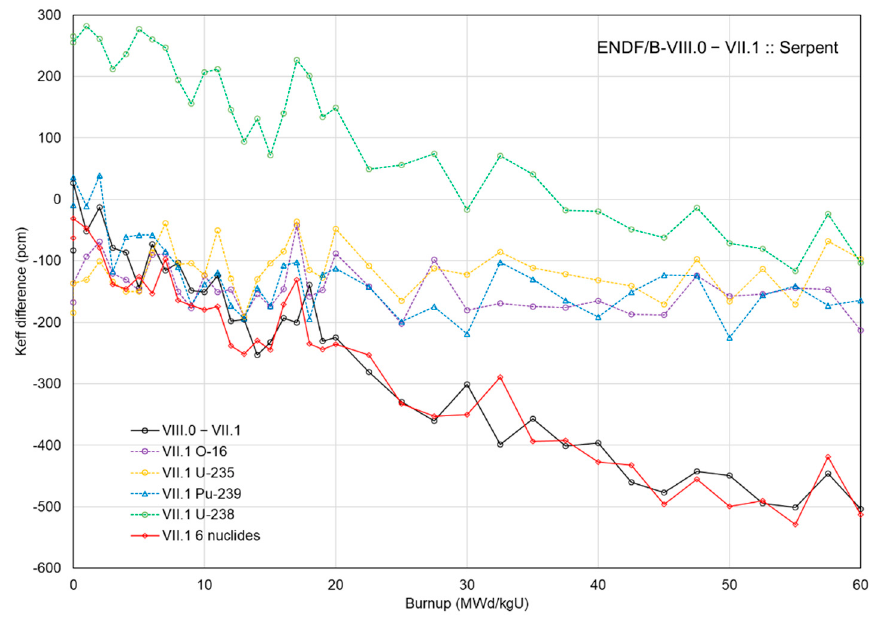
Figure 2. Most influential nuclides in ENDF/B-VIII.0.